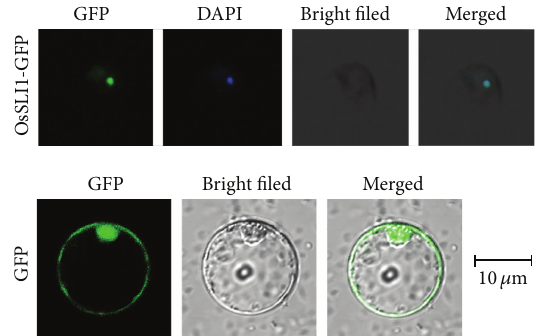
Figure 6: Nuclear localization of OsSLI1-GFP fusion protein. Con- structs of 35S:OsSLI1-GFP (above) and 35S:GFP were transformed into rice protoplast cells, respectively. The GFP and DAPI signals were observed by confocal microscopy.